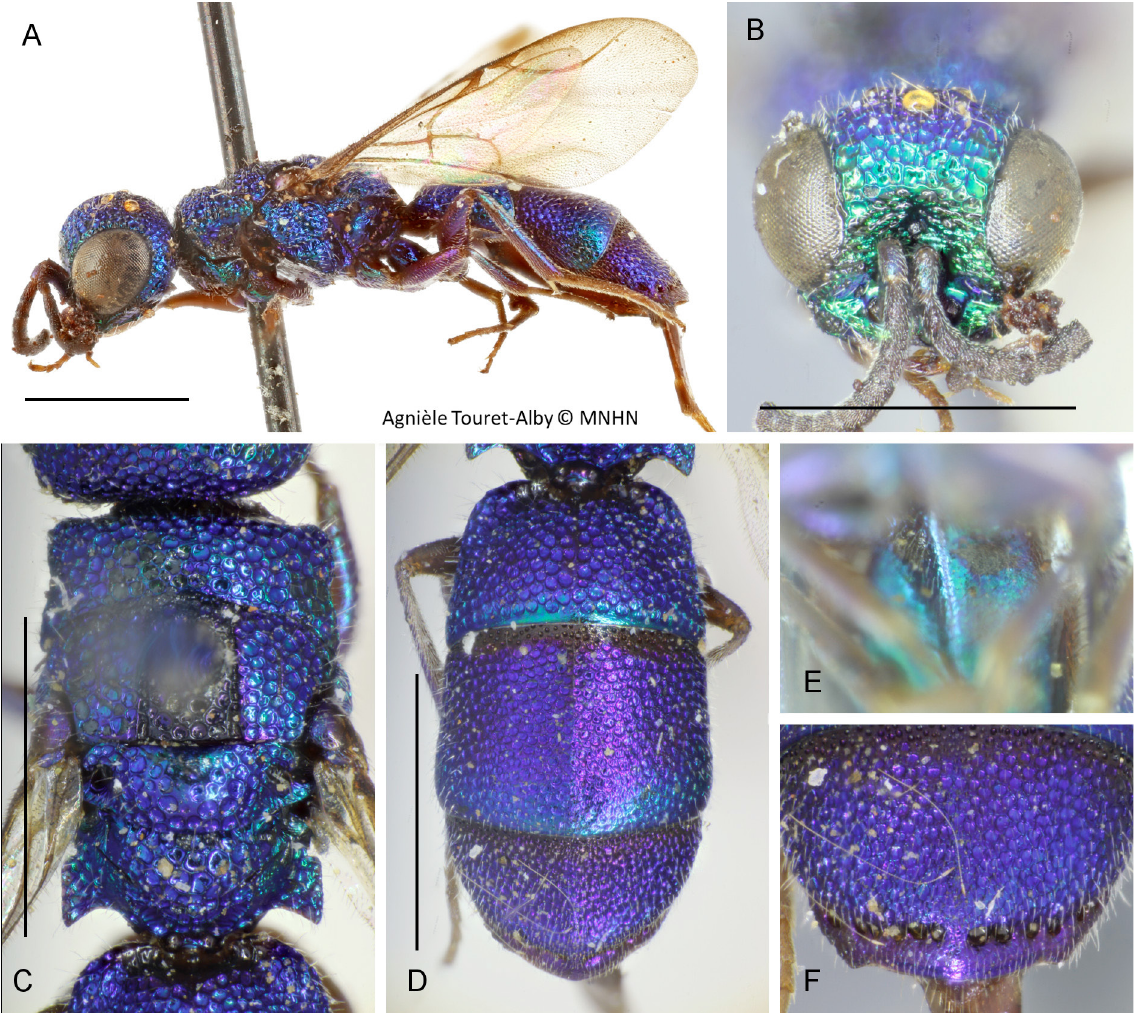
Fig. 1. Chrysidea pumiloides Zimmermann, 1956, holotype, ♀. A . Lateral habitus. B . Head. C . Mesosoma. D . Metasoma. E . Black spots on S2. F . T3. Scale bars = 1.0